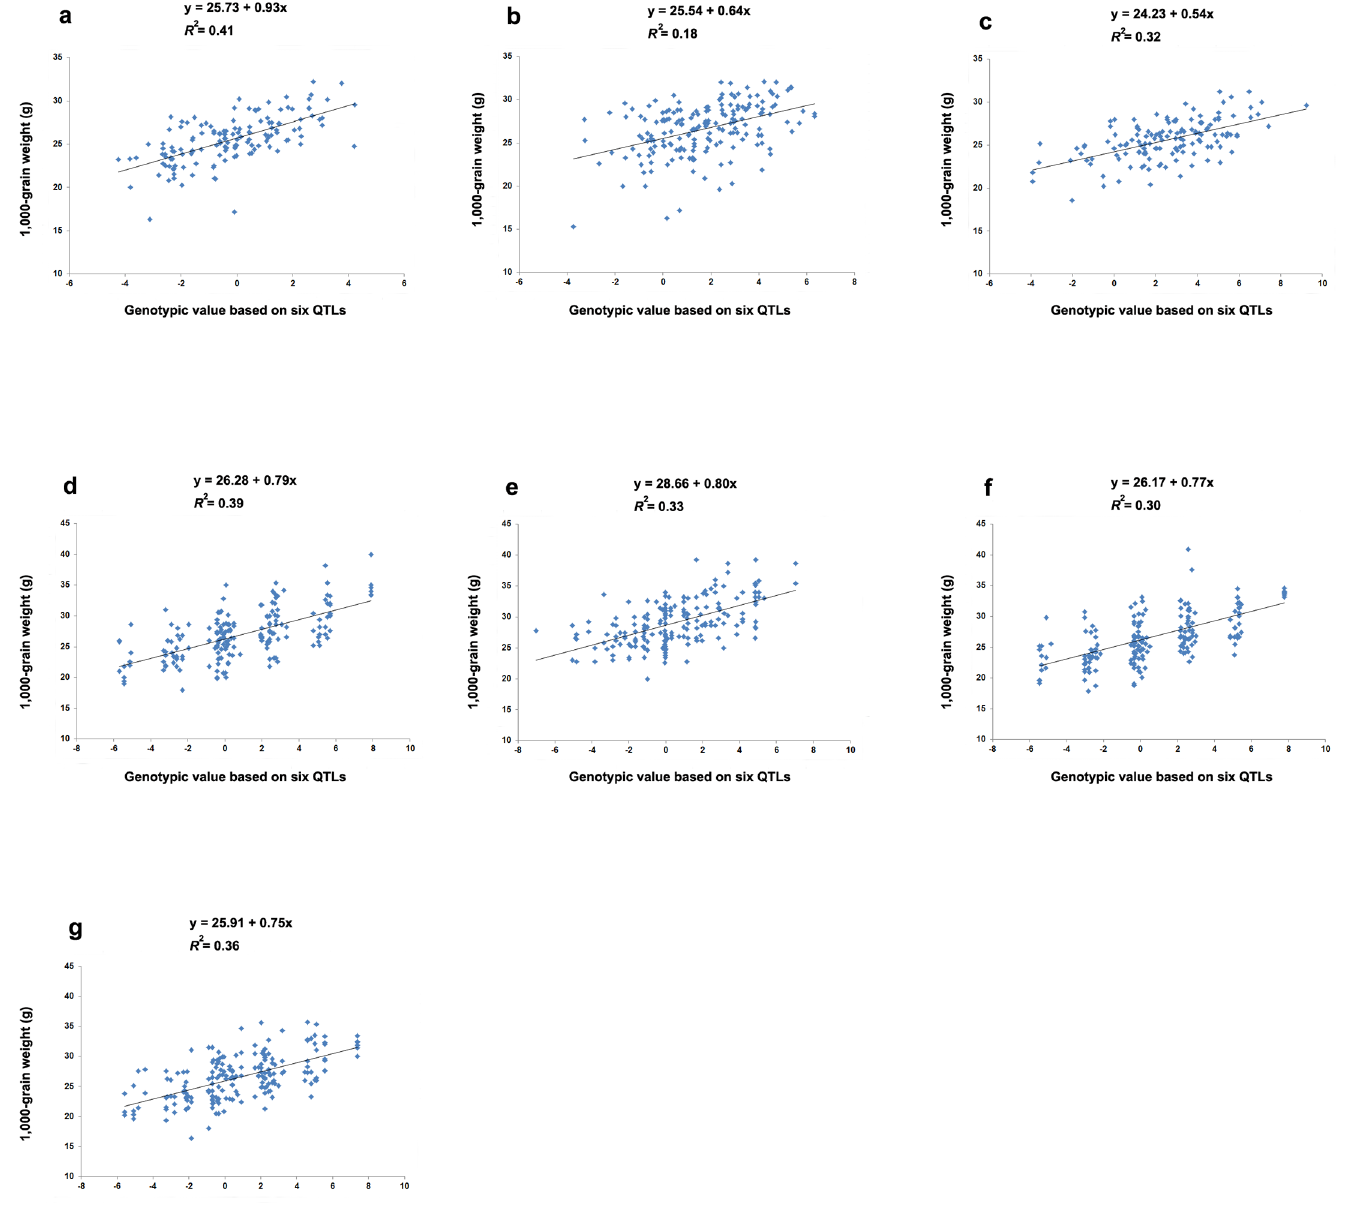
Fig 2. Linear regression analysis between 1000-grain-weight and genotypic values of individual plants/lines in the seven mapping populations (two F 2 , one F 3 , and four recombinant inbred line (RIL) populations), derived from ‘Lemont’ × ‘Yangdao 4’ and grown under different environmental conditions. ( a ) F 2 populationgrown in 2011 in Hangzhou,( b ) F 2 populationgrown in 2012 in Hangzhou, ( c ) F 3 populationgrown in 2012 in Hainan,( d ) F 7 RIL population grown in 2014 in Hangzhou,( e ) F 8 RIL population grown in 2014 in Hainan,( f ) F 9 RIL populationgrown in 2015in Hangzhou, and ( g ) F 10 RIL population grown in 2015 in Hainan.The genotypicvalue of each individual plant/line was calculatedby addingthe estimated additiveeffects of the six quantitative trait loci (QTLs) in the RIL populations, or by addingthe estimated additive effects and dominanceeffects of the six QTLs in the F 2 populations. The dominanceeffects of the heterozygotes were summed to the additive effects of the homozygotes across the six loci to determine QTL genotypicvalues in the F 2 populations. When calculatinggenotypicvalues, a positive additiveeffect was used if a locus carried a grain- weight-increasingallele, and a negative additiveeffect was used if a locus carried a grain-weight-decreasing allele.